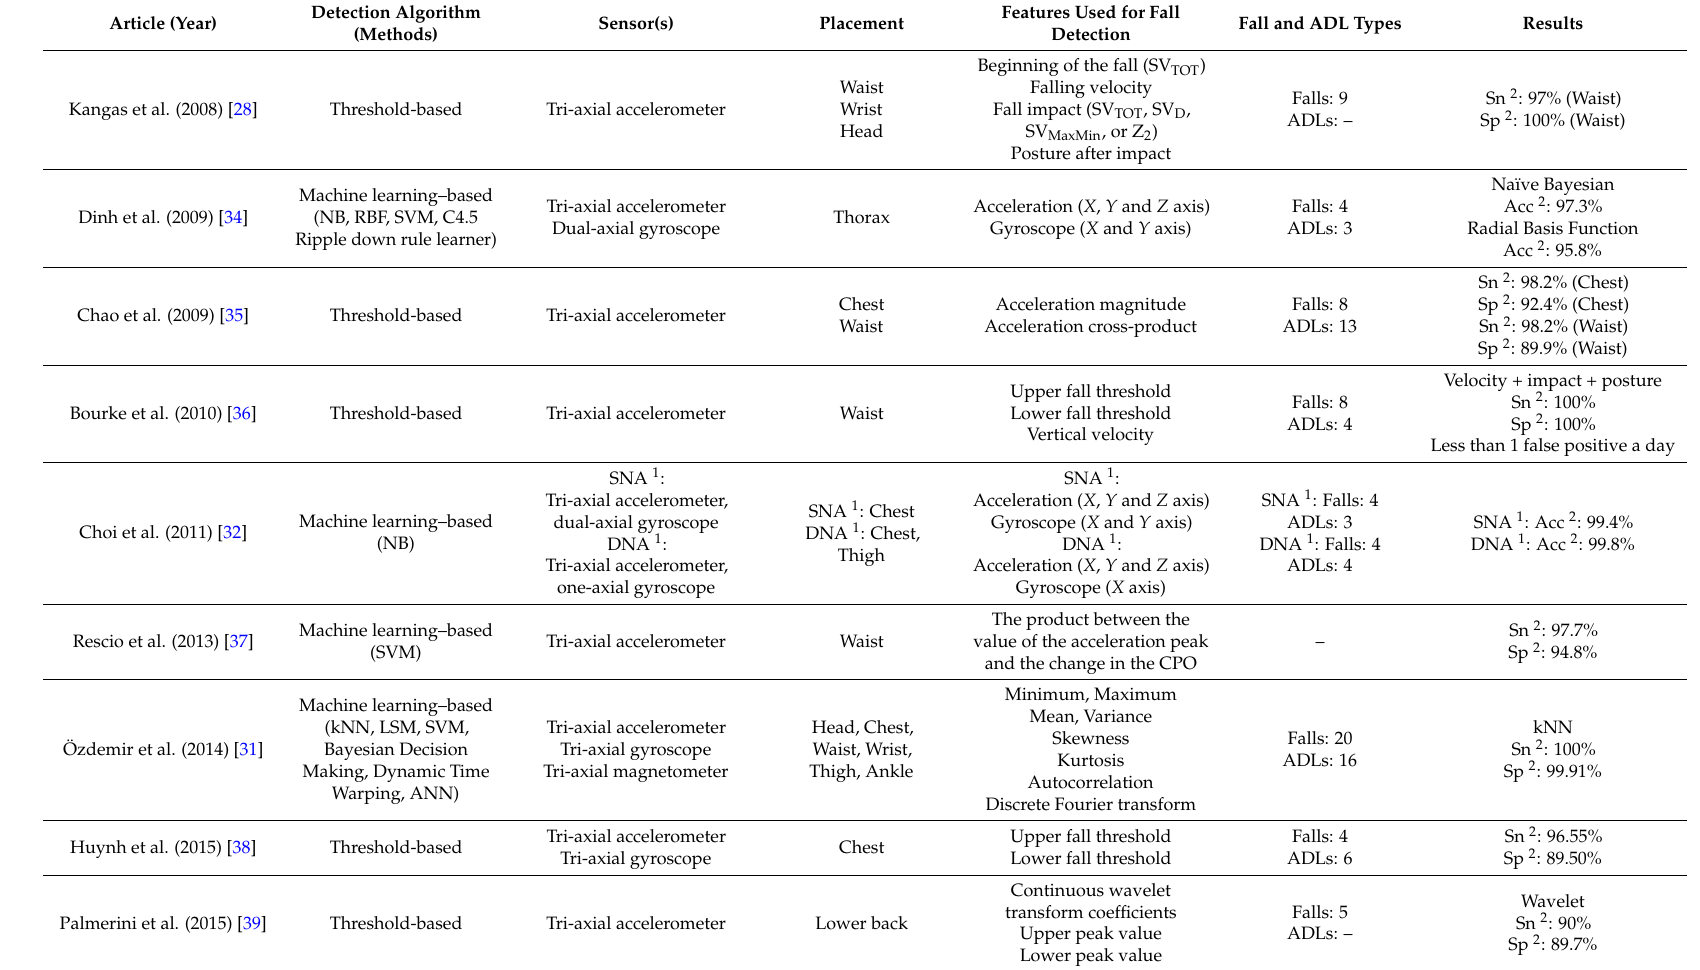
Table 1. Literature of automatic fall detection